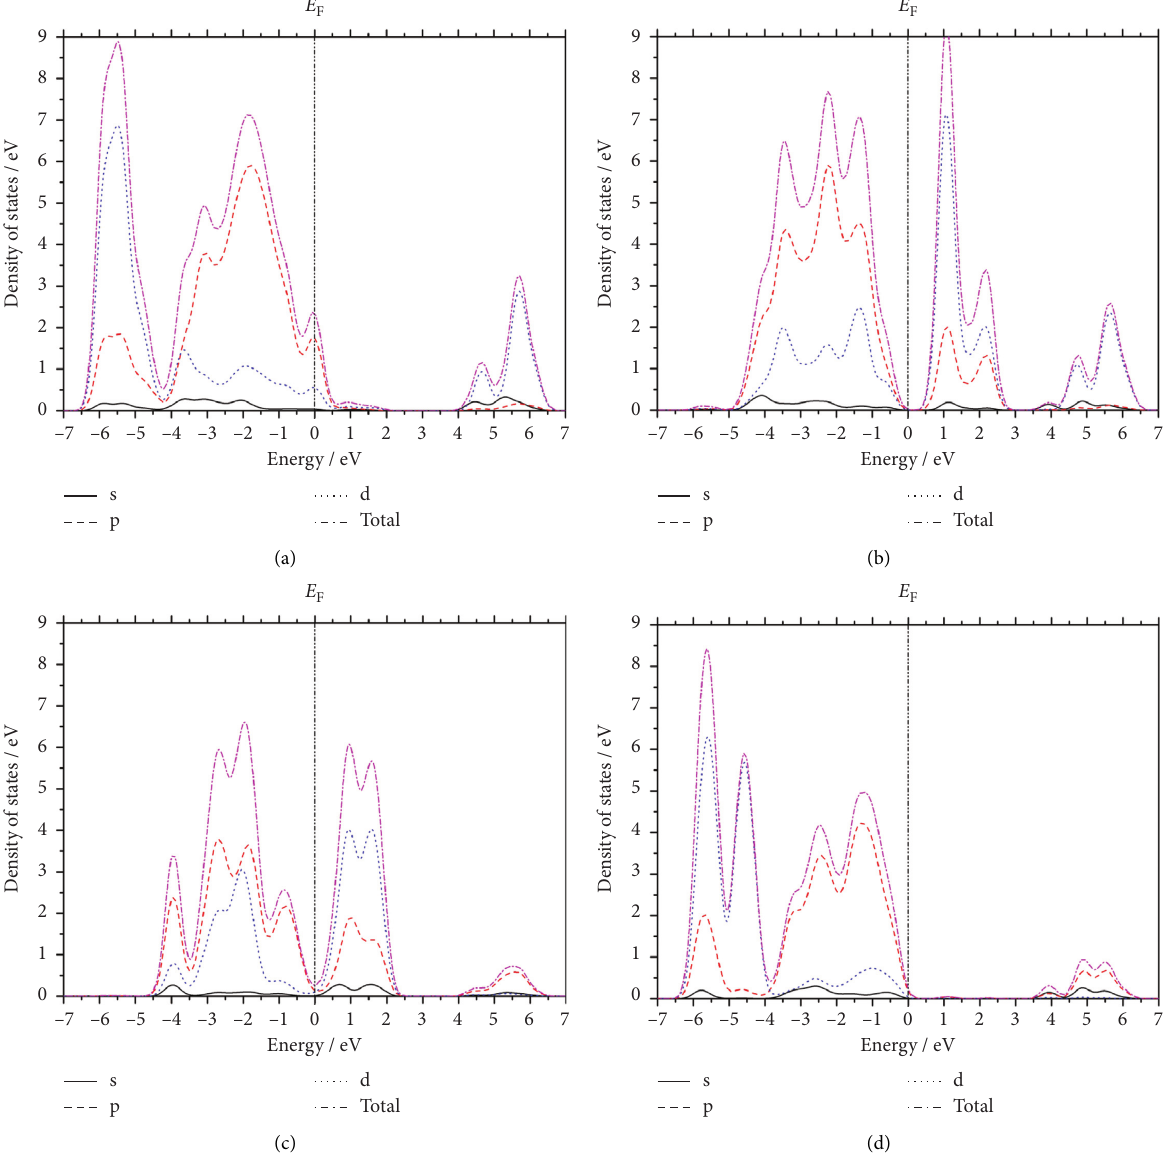
Figure 8: Detailed electron density of states of CaCoO layer (a for spin-up and b for spin-down) and CoO spin-down) for sandwiched Ca 2 Co 2 O 5 crystalline